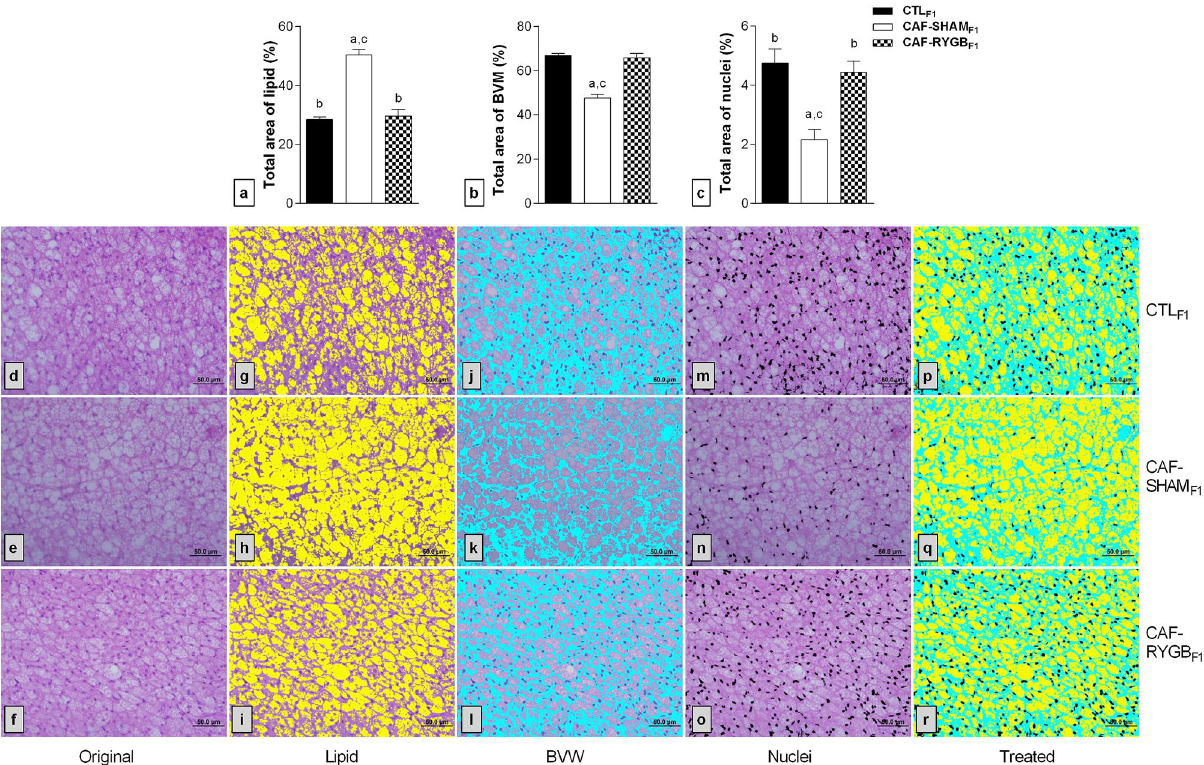
Figure 4. Effect of maternal obesity and RYGB on the distribution of fat, nuclei and BVM in the BAT of male adult offspring rats. CTL F1 , offspring of rats fed standard diet; CAF-SHAM F1 , offspring of rats fed on CAF diet and submitted to sham operation; CAF-RYGB F1 , offspring of rats fed on CAF diet and submitted to RYGB (n = 6 animals/group). The percentages of the total area occupied by lipids ( a ), BVM ( b ) and nuclei ( c ) were analysed. Different letters indicate statistical differences by one-way ANOVA and Bonferroni post-test ( p < 0.05). Representative photomicrograph (insert) of BAT (40x), stained with H&E are showed in the figures ( d ) (CTL F1 ), ( e ) (CAF-SHAM F1 ) and ( f ) (CAF-RYGB F1 ). The images were processed with Image J Program as explained in methods section. Groups are in rows. CTL F1 , CAF-SHAM F1 and CAF-RYGB F1. In columns original image ( d – f ), adipocytes in yellow ( g – i ), BVM in blue ( j – l ) and Nuclei in black ( m – o ). Fully treated image ( p – r ). The data are means ±